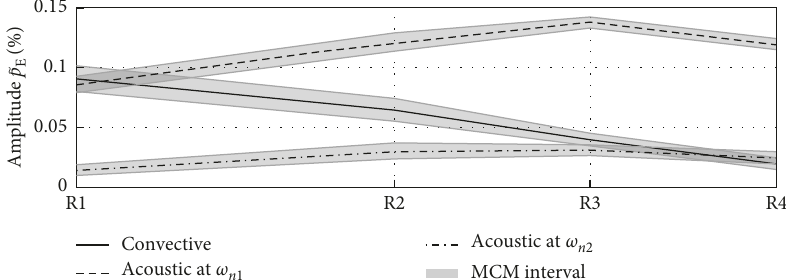
Figure 16: The calculated amplitudes from the fitting coefficients in Table 4 for R1–R4. The distance between the sensors is according to Figure